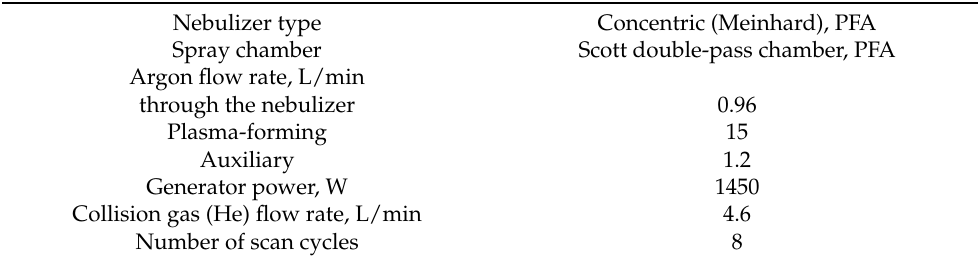
Table 2. The operating mode of the NexION 300D instrument for conducting impurity analysis of samples with Gd matrix